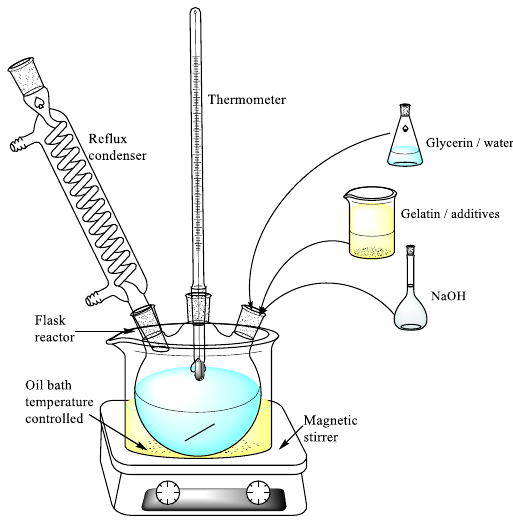
Figure 13. Method of blend synthesis. Table 7. Components used for blends’ synthesis. Amounts are presented in parts by weight